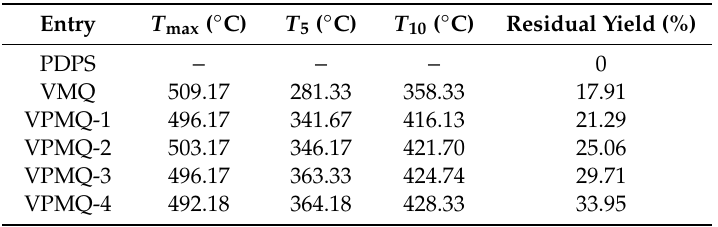
Table 3. The characteristic degradative data of VMQ and VPMQ